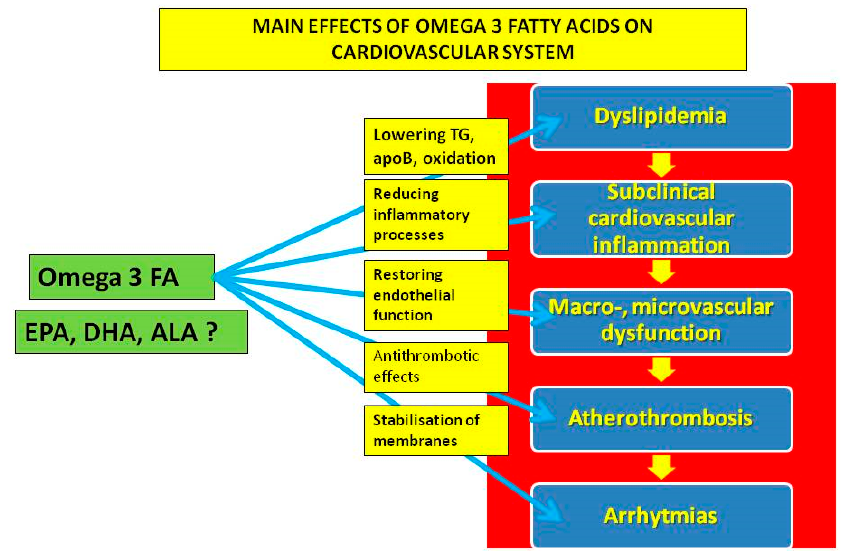
Figure 2. The main potential effects of omega-3 fatty acids on the cardiovascular system. Table 1. Main clinical trials focused on the effect of n-3 PUFAs on cardiovascular events (created partly on information and data from [25]).